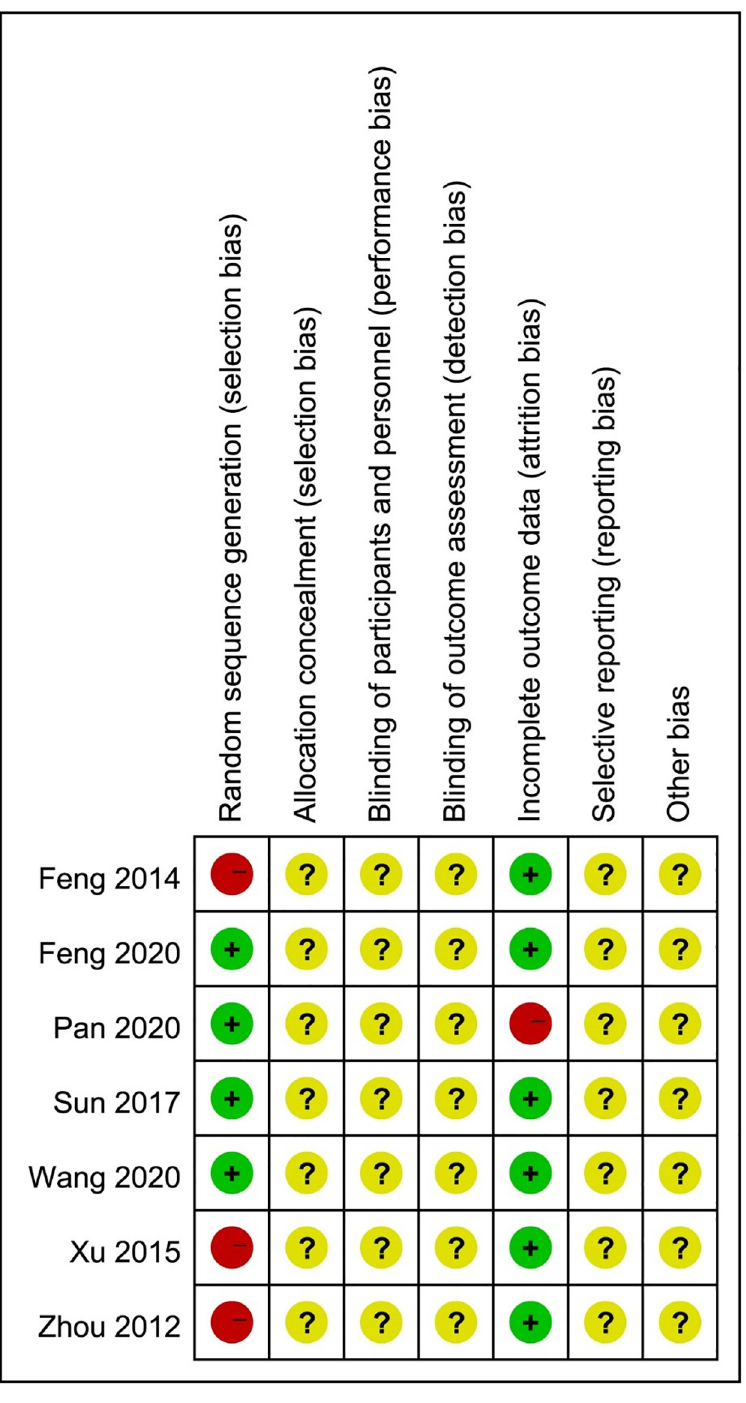
Fig 2. Risk of bias in included